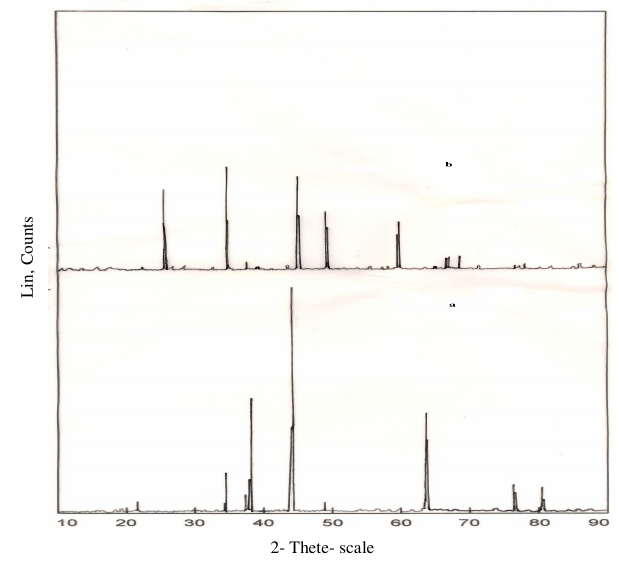
; (b)LiNI La O 2 0.75 0.25 2